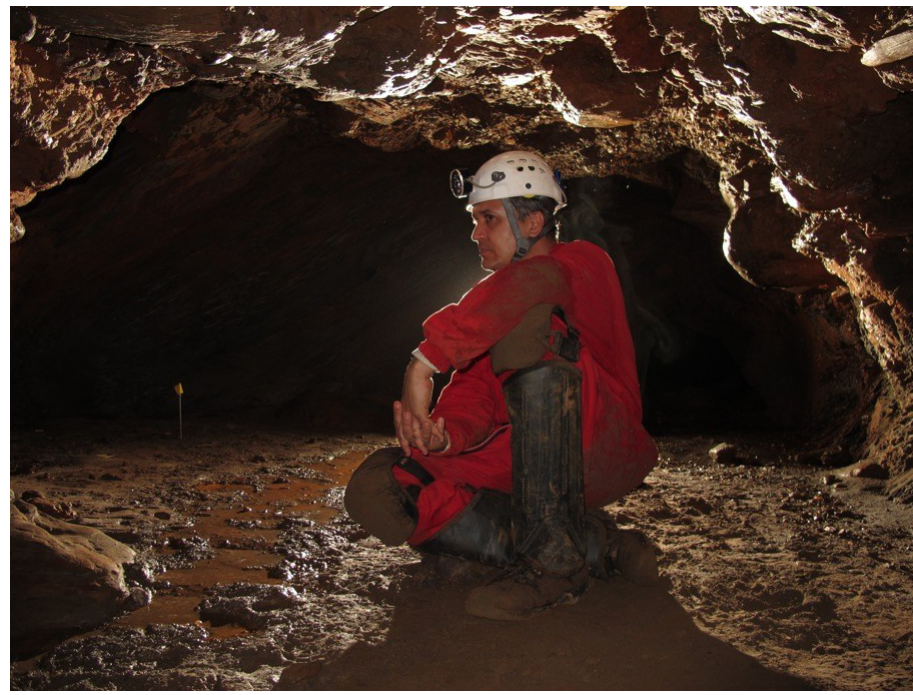
Figure 1. Interior of a cave adjacent to an Anglo American PLC mining site in Conceição do Mato Dentro CAI-03. Caver (standing, approximately 1.9 m tall) provided for scale. The cave passage is approximately 1 m